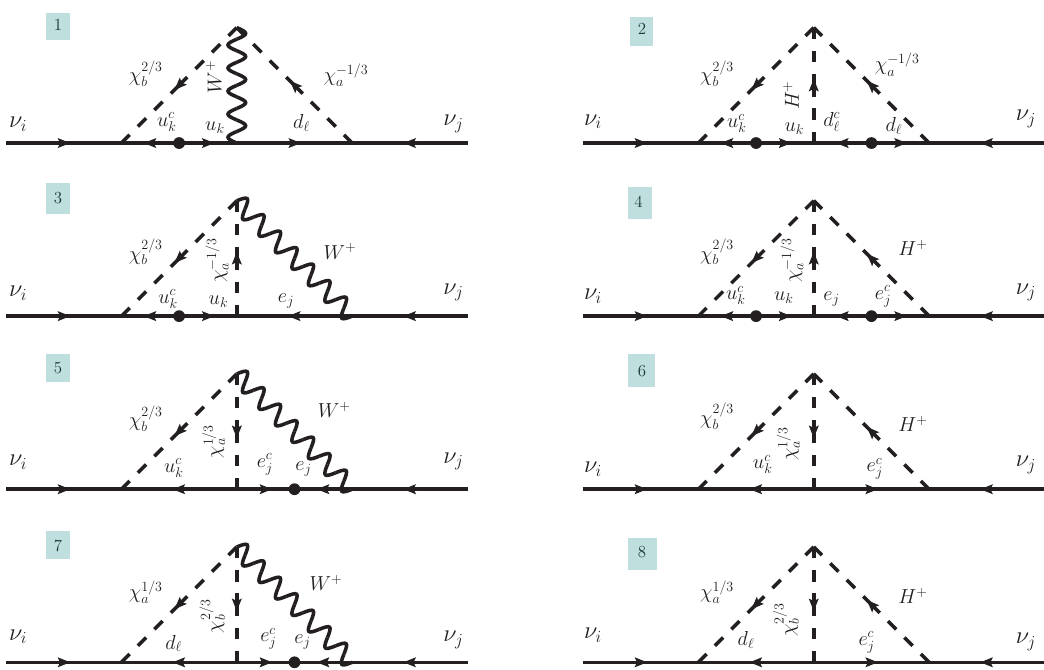
Figure 2 . All two-loop diagrams leading to neutrino mass generation. These Feynman diagrams are presented in the mass eigenstate